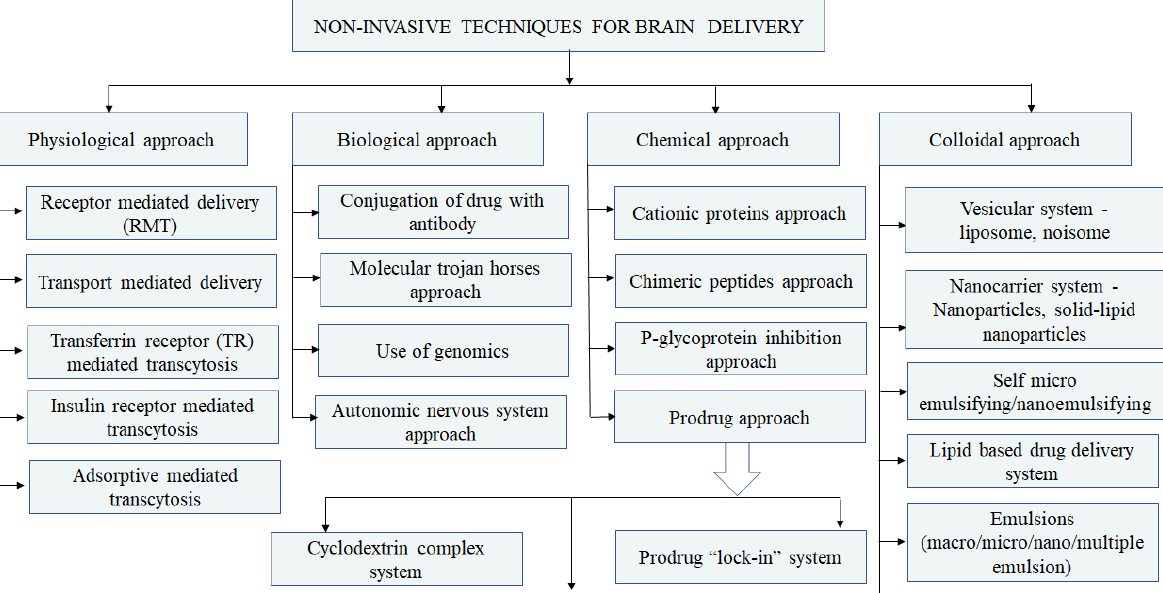
Fig. 3. Approaches for brain targeted drug delivery